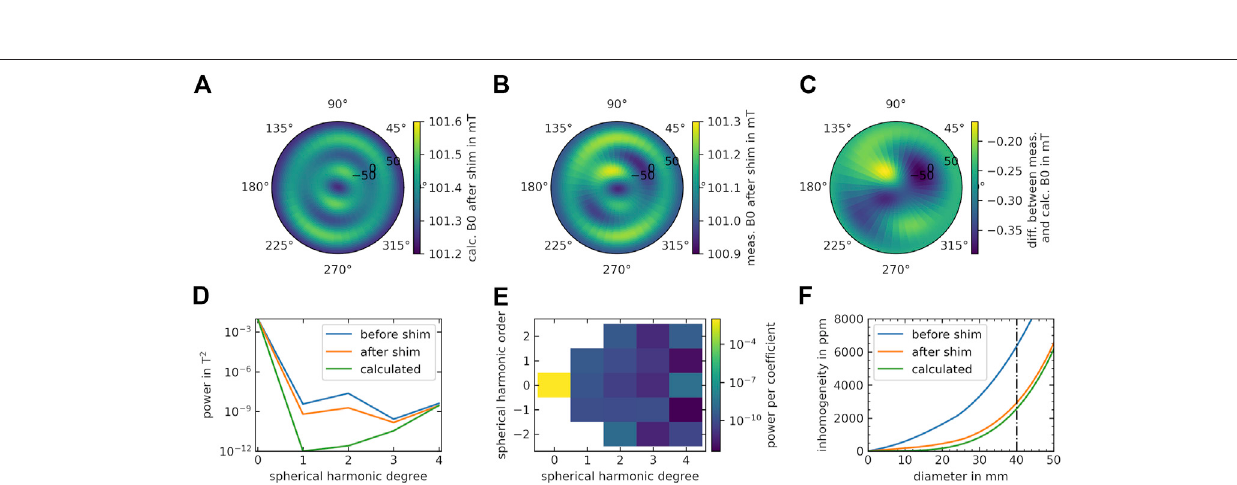
FIGURE 9 | Measured fi eld distribution after shimming for a 3D target sphere. The magnetic fi eld distribution is depicted in polar projection of the fi eld. (A) Calculated fi elddistributionaftertheshimdeterminedbythegeneticalgorithmwiththedipoleapproximation. (B) Measured fi elddistributionaftertheshim. (C) Difference betweenthemeasuredandpredicteddata. (D) Powerpersphericalharmonicdegreepresentintheunshimmeddesktopmagnet(blue)anddeterminedaftertheshimby measurement (orange)andbycalculationwiththegeneticalgorithm(green). (E) Powerper sphericalharmoniccoef fi cientforthemeasured fi eldaftershimming. (F) Field inhomogeneity in the target region of the desktop MR magnet. The data is reconstructed from fi eld data measured on a 4 cm sphere using truncated spherical harmonics and plotted along the diameter of the three-dimensional sphere for the unshimmed (blue), shimmed (orange) magnet and predicted by the algorithm (green). The dash-dotted line indicates the diameter of the measured target